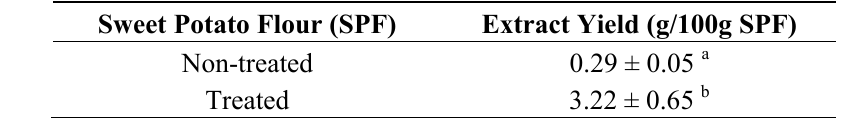
Table 1. Extract yield of sweet potato flour (SPF) as subjected to simulated gastrointestinal pH